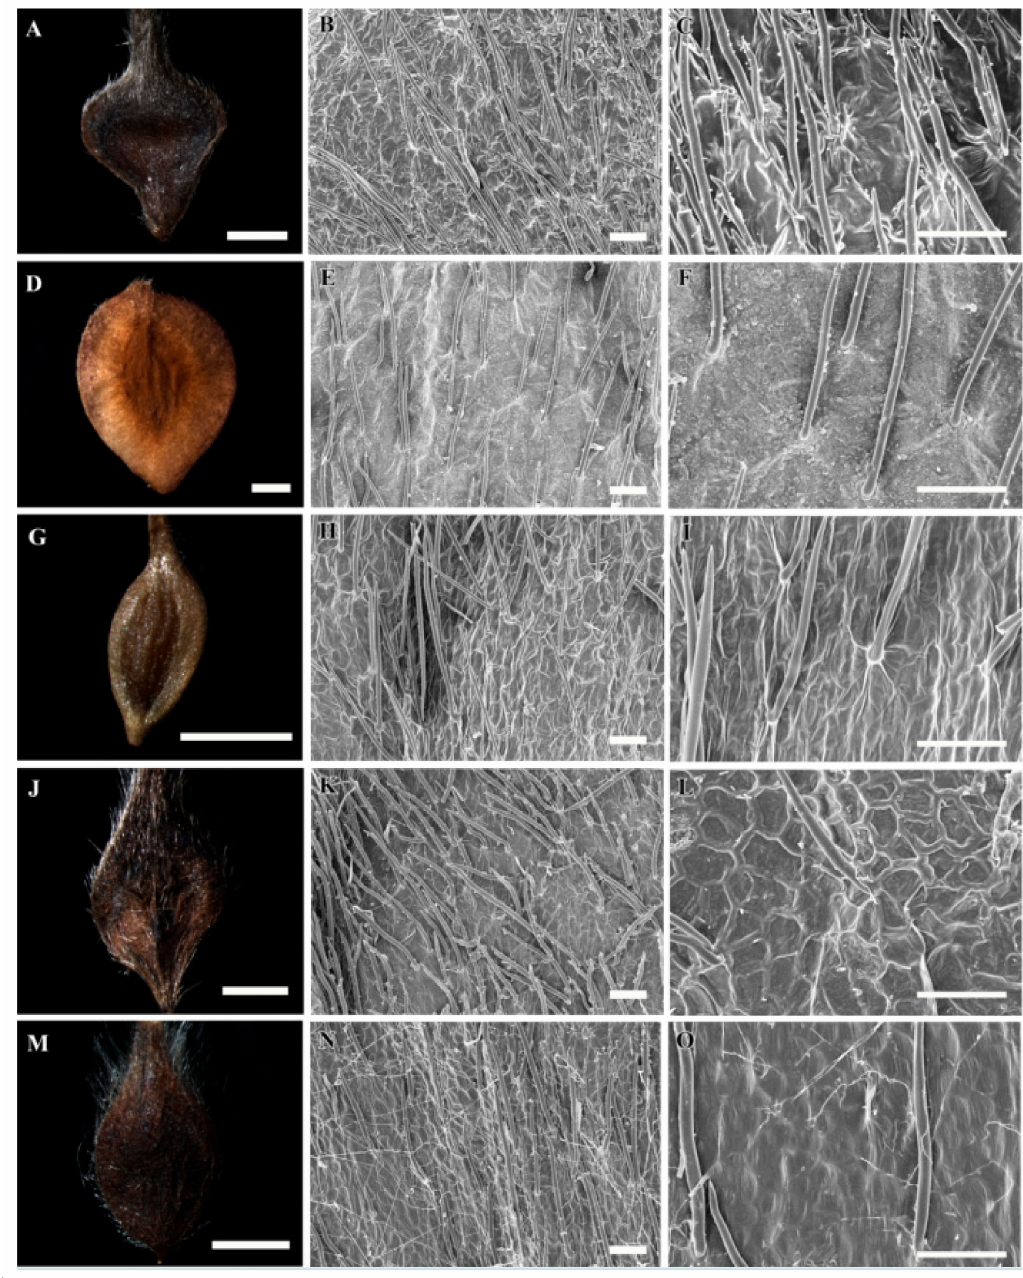
Figure 3. Stereomicroscopic and scanning electron microscopic micrographs of achenes of Clematis . ( A – C ) C. patens . ( D – F ) C. brachyura . ( G – I ) C. serratifolia . ( J – L ) C. fusca var. fusca . ( M – O ) C. fusca var. flabellata . Scale bars: 2 mm ( A , D , G , J , M ); 100 µ m ( B , C , E , F , H , I , K , L , N , O